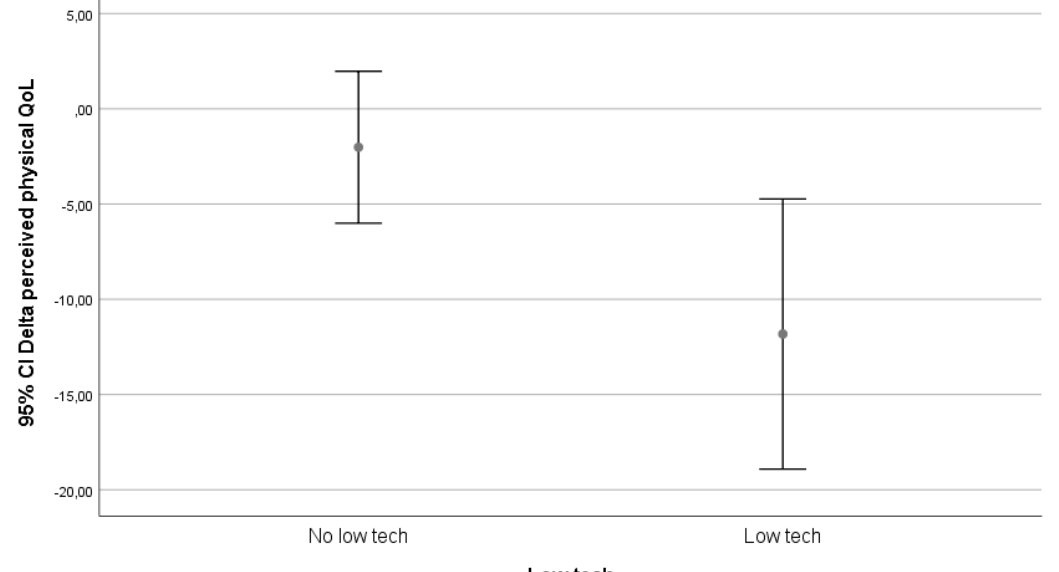
Figure 3. Relation between delta perceived physical health (SF-12 (physical health T12) – SF-12 (physical health T0) ) and match to low-tech technology.